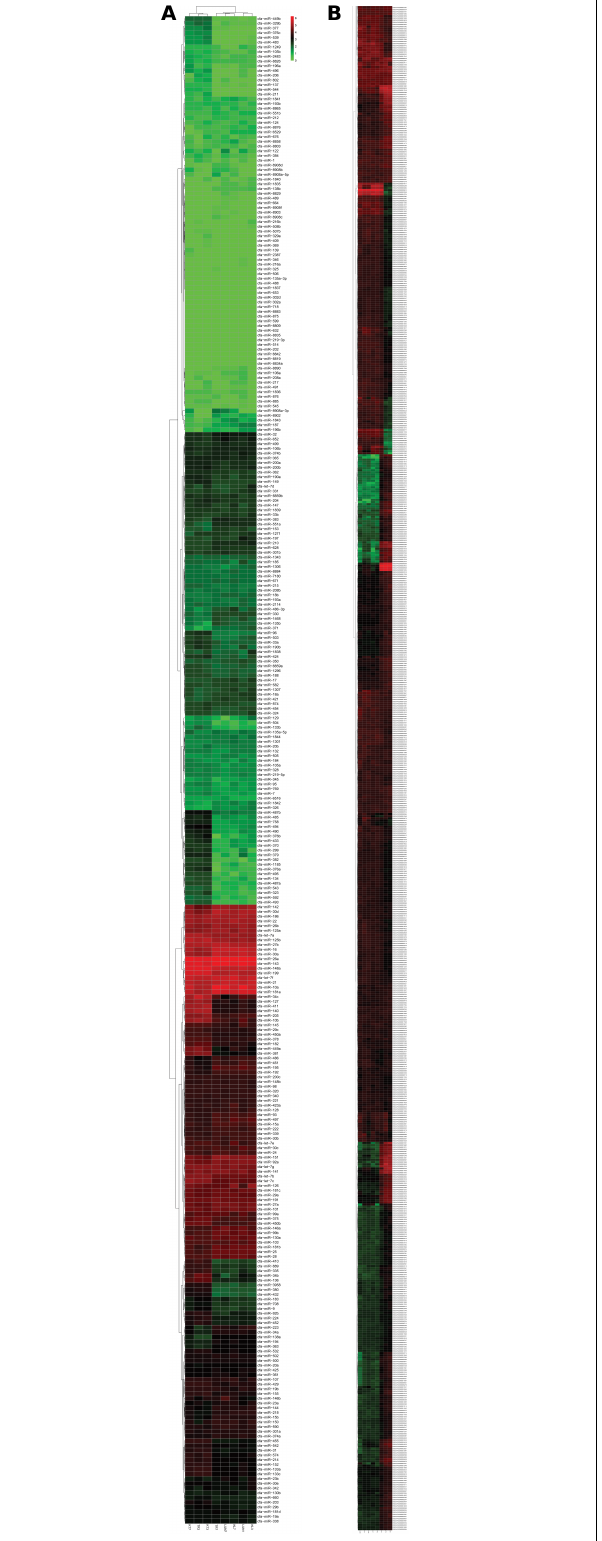
FIGURE 1 | (A,B) Hierarchical clustering of DE miRNAs and DE mRNAs among eight RNA libraries. Heatmap of the number of DE miRNAs and DE mRNAs libraries for the DEGs between the infected groups and non-infected groups. MiRNA and mRNA heatmaps of all DE miRNAs and mRNAs are